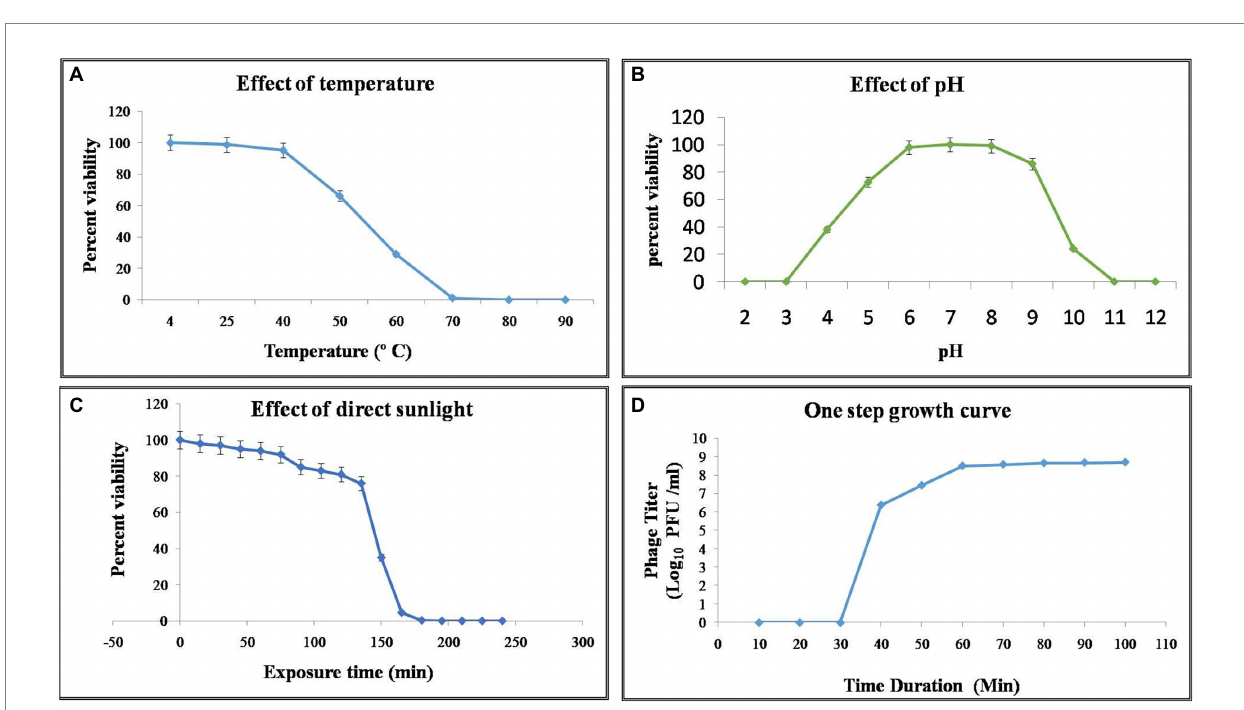
FIGURE 4 Effect of environmental condition on the viability of phage NR08. (A) Effect of temperature on viability; (B) effect of pH on viability; (C) effect of direct sunlight on viability; and (D) one-step growth curve of phage